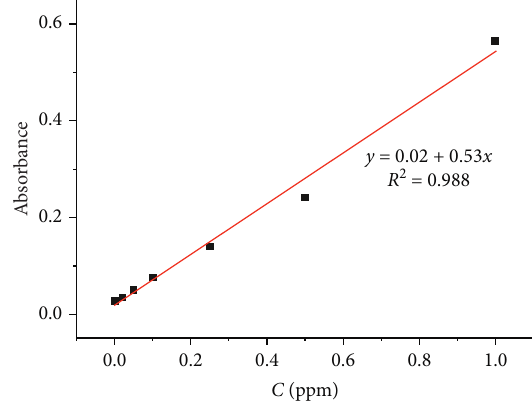
Figure 4: The external UV standard curve used in determining Cr(VI) concentrations in test solutions at 530nm